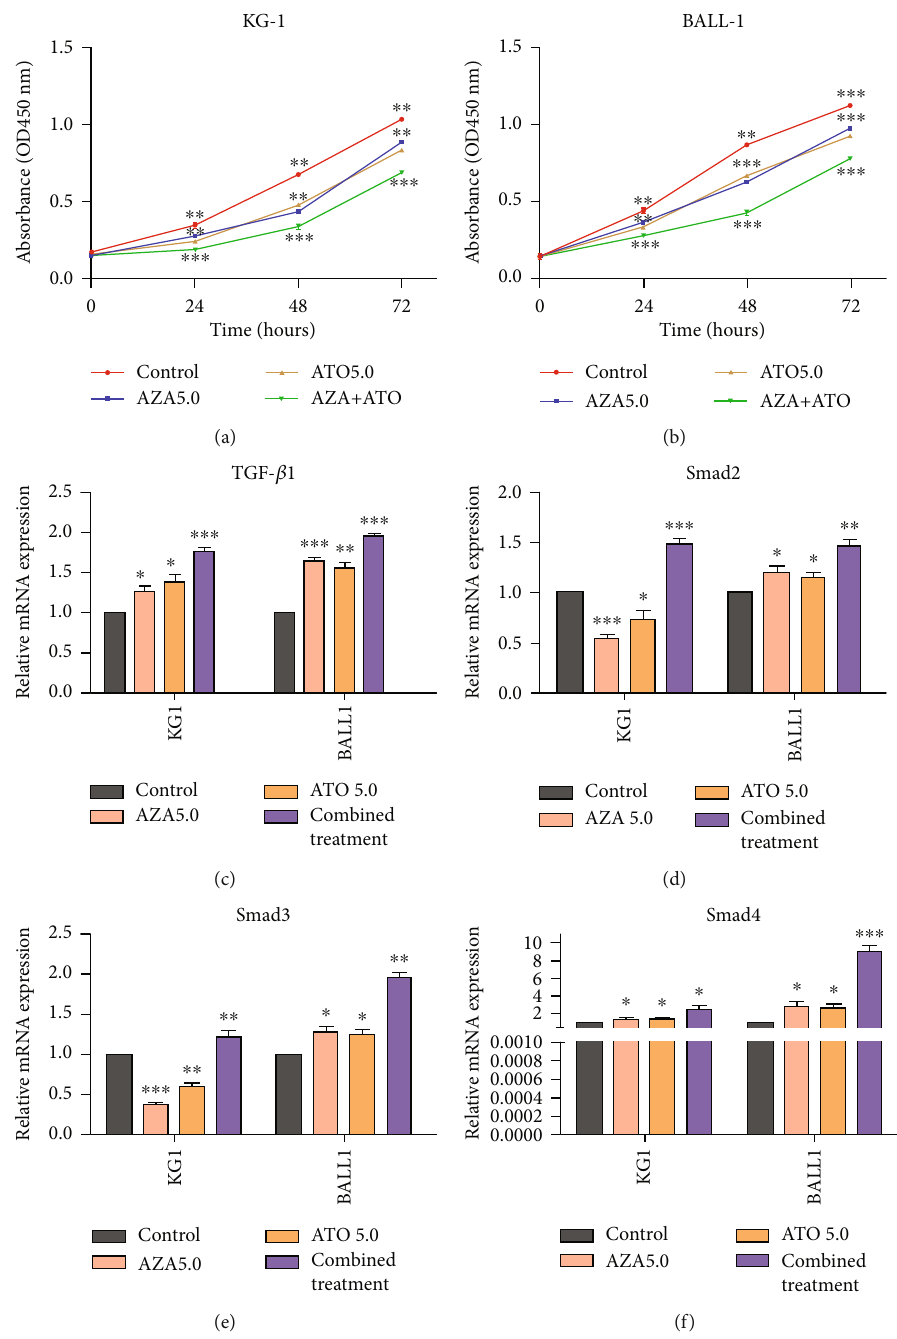
Figure 4: The e ff ects of 5-azacytidine combined with arsenic trioxide on the viability of acute leukemia cells and the TGF- β signaling pathways. (a, b) The e ff ects of 5-azacytidine combined with arsenic trioxide on the viability of acute leukemia cells. (c – f) The e ff ect of 5- azacytidine combined with arsenic trioxide on TGF- β signaling